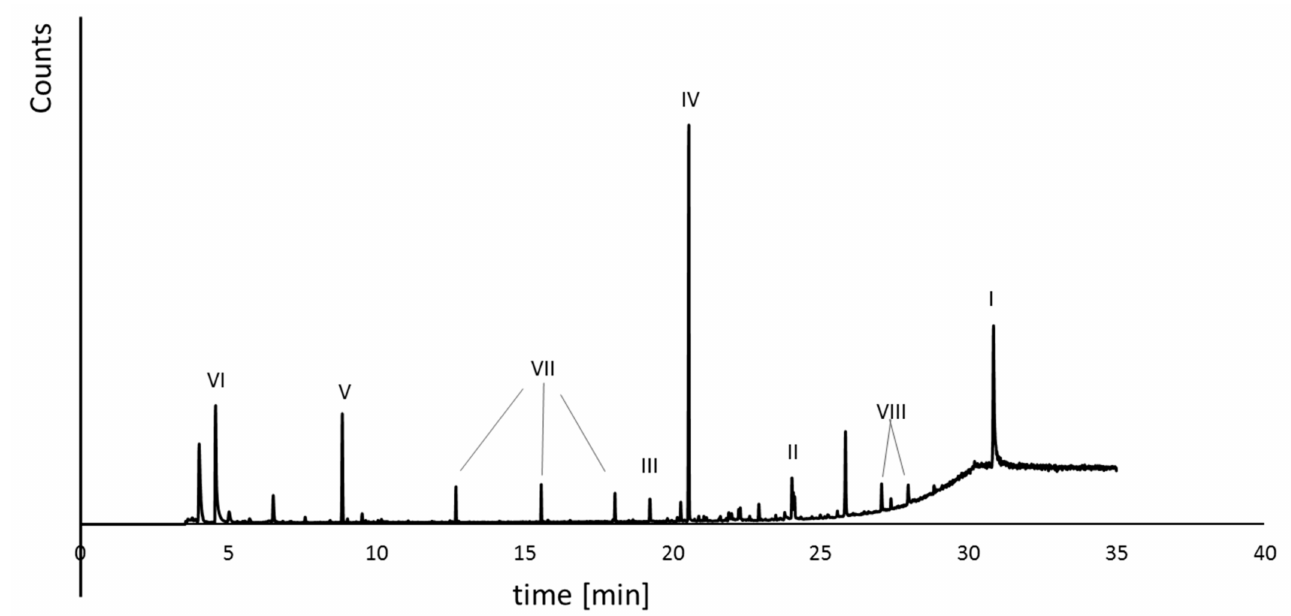
Figure 5. Exemplary GC-MS analysis of the reaction mixture, where I—TBBPA; II—BPA; III—3,5-dibromo-4-hydroxybenzoic acid; IV—2,6-dibromo-4-isopropylphenol; V—2,6-dibromo-4- methylphenol; VI—DMSO; VII—aliphatic carboxylic acids; VIII—tri-, di-, mono-bromobisphenol